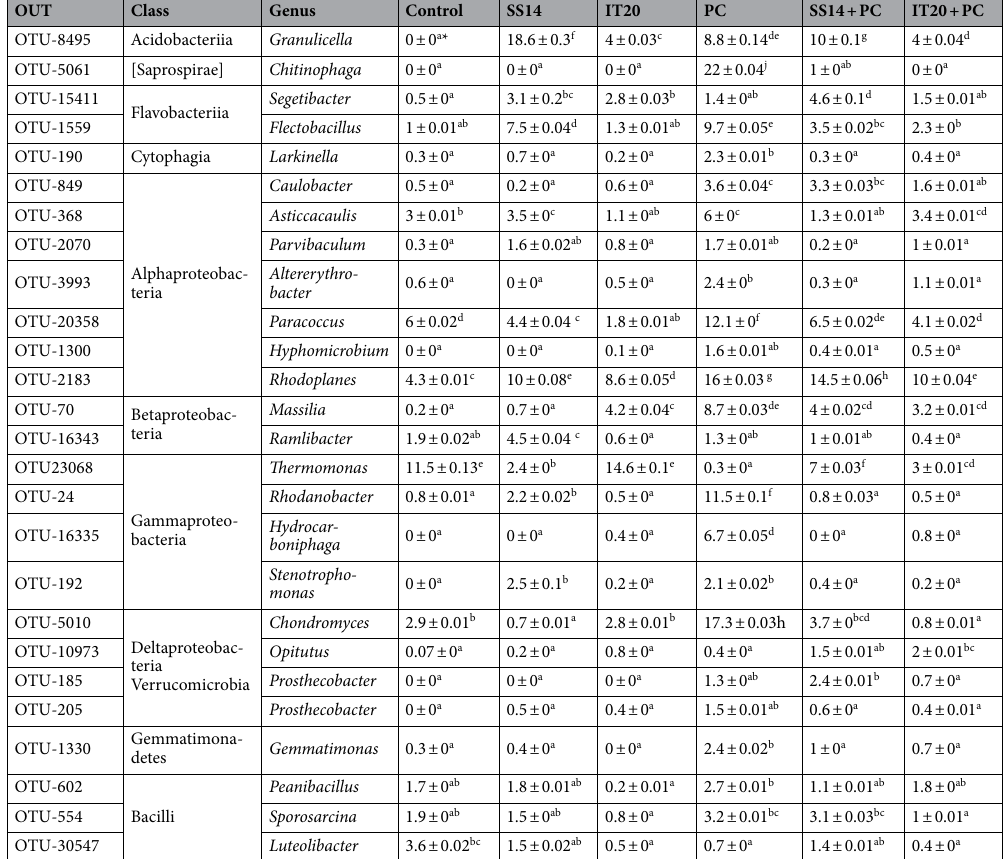
Table 4. Influence of P. capsici on the prokaryotic community composition of pepper rhizosphere. Values are the mean percentages (averaged from three replicates) ± SE. *Same letters represent non-significant difference according to Duncan’s Multiple Range under a generalized linear model (GLM) ( P < 0.05